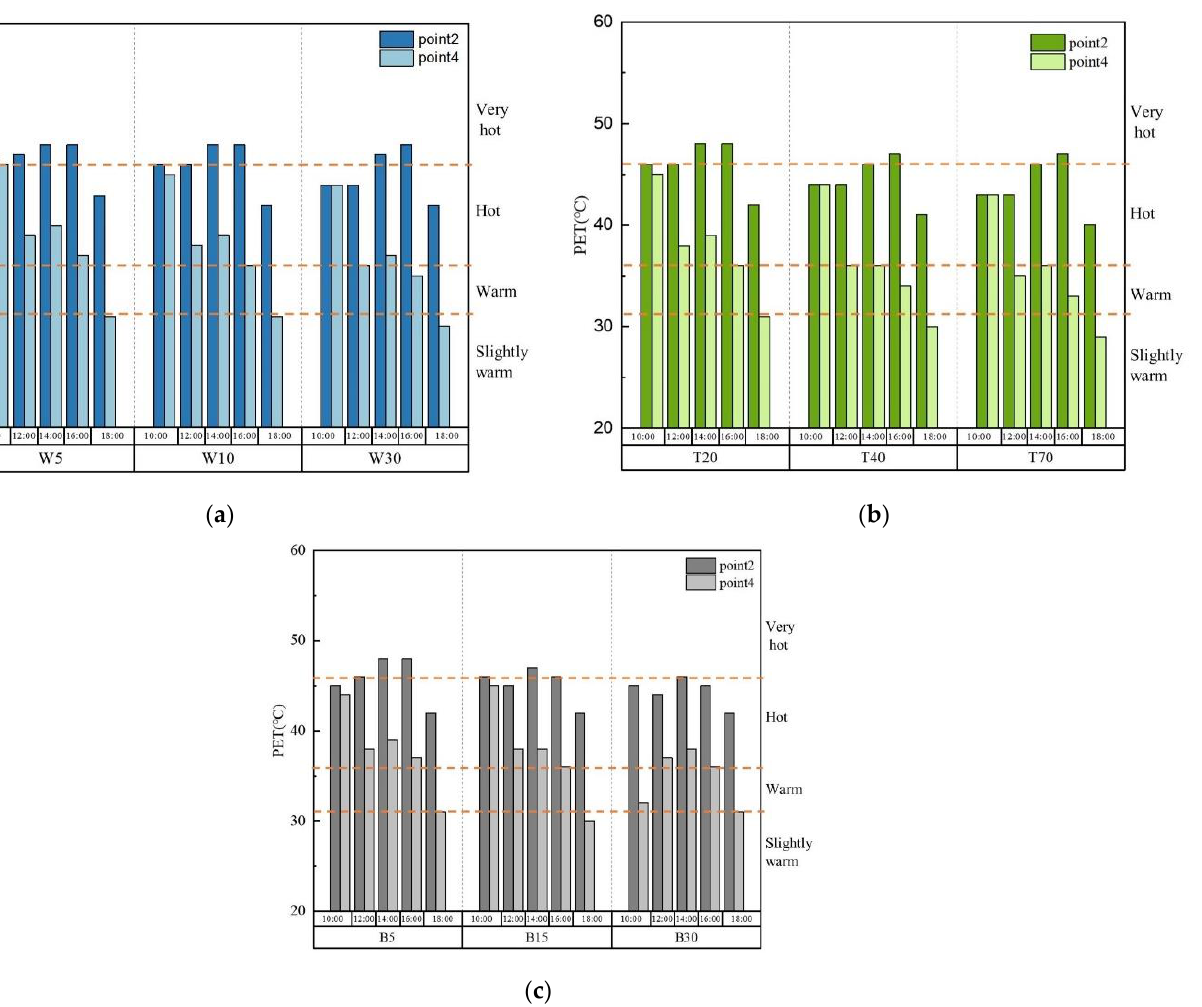
Figure 10. Time course of PET values at sites 2 and 4 in the redesigned cases: ( a ) water bodies; ( b ) vegetation; and ( c ) buildings.